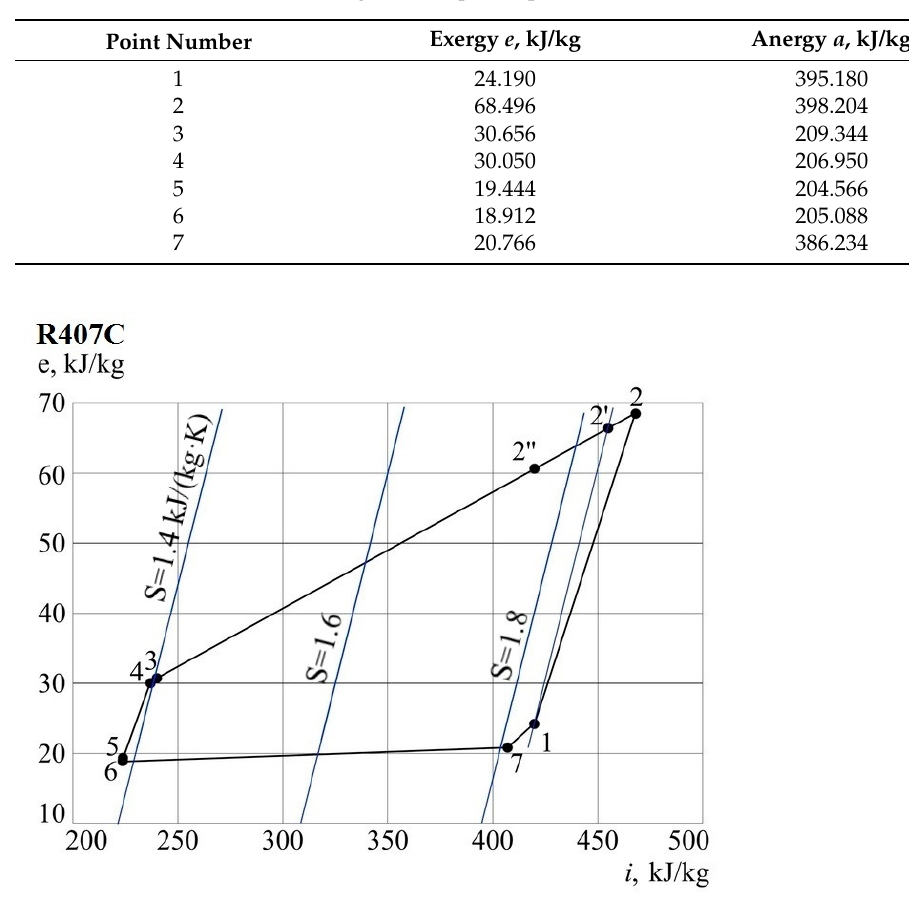
Table 5. Characteristics of the refrigerant at specific points.